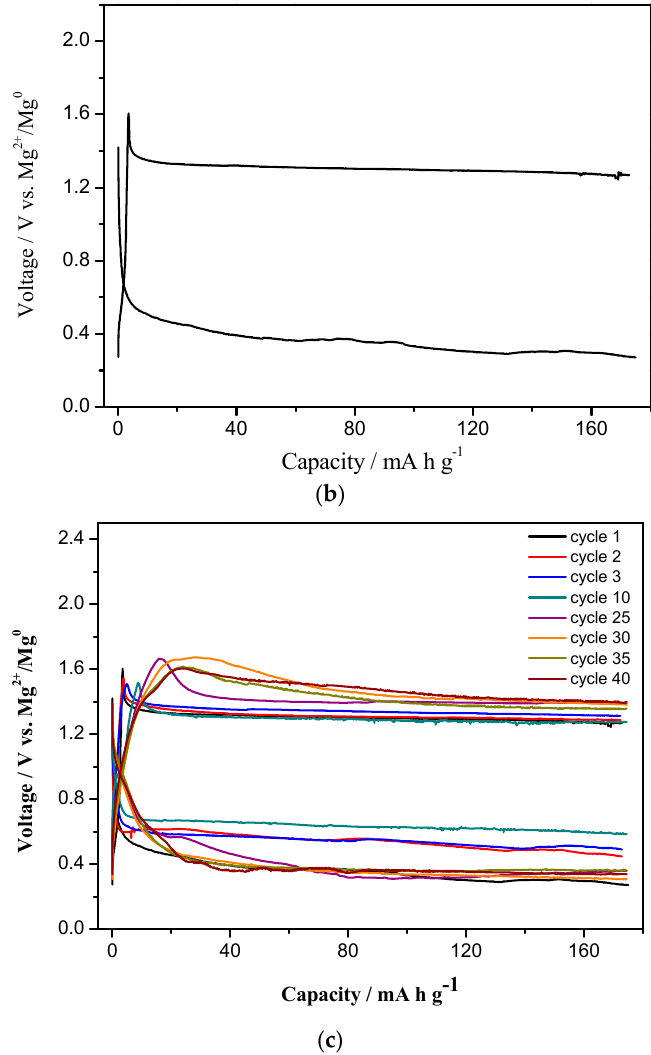
Figure 3. ( a ) Cyclic Voltammetry of LTO with 0.5 M Mg(TFSI) 2 + 0.13 M MgCl 2 ·6H 2 O in DME versus Mg as reference and counter electrode. Galvanostatic discharge/charge curves of LTO sample in a three-electrode Mg cell using: ( b , c ) 0.5 M Mg(TFSI) 2 + 0.13 M MgCl 2 ·6H 2 O in DME cycled at 0.1 C.